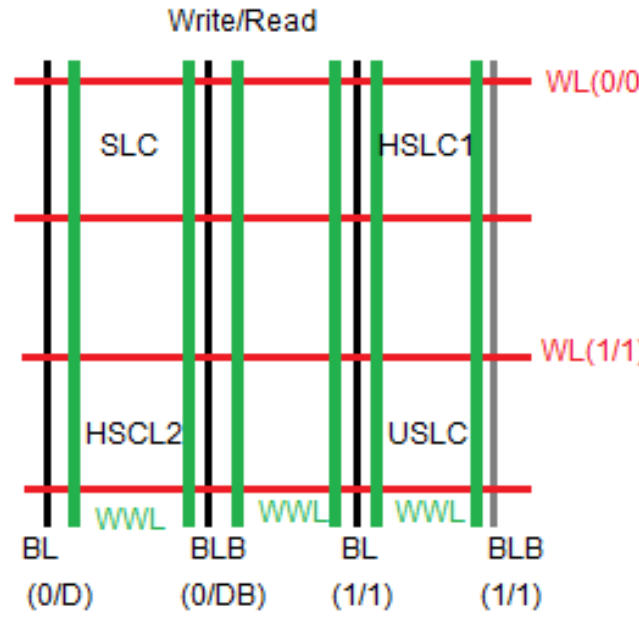
Figure 11. Bit-interleaving aware array